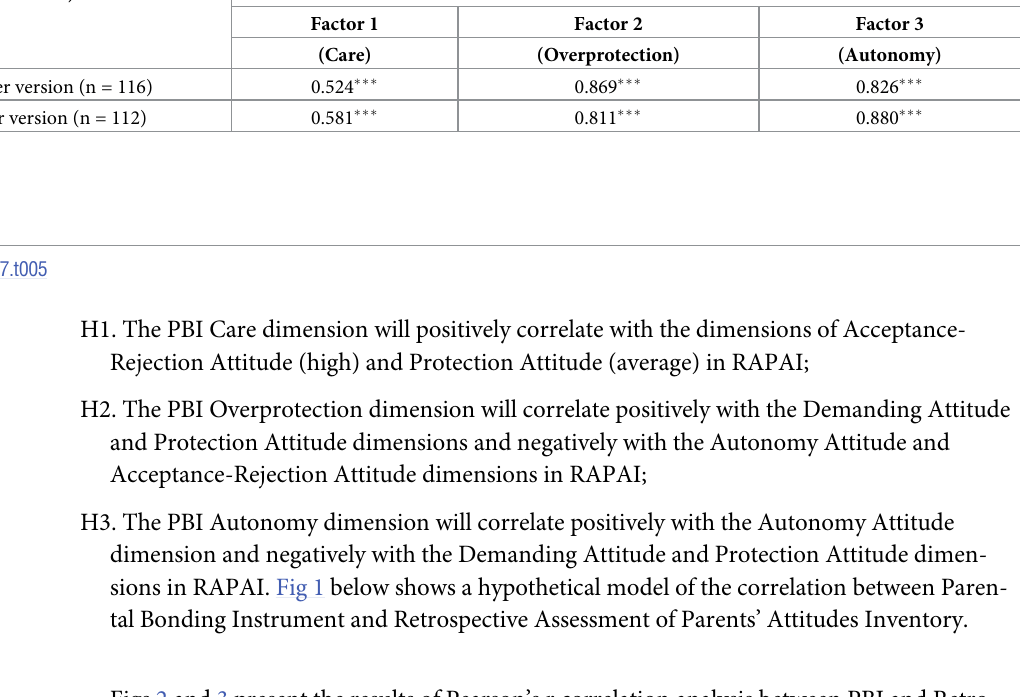
Table 5. 3 weeks test–retest correlation for the factors of mater and father PBI version (retest for mothers n = 116; retest for fathers n = 112). TEST–RETEST (after 3